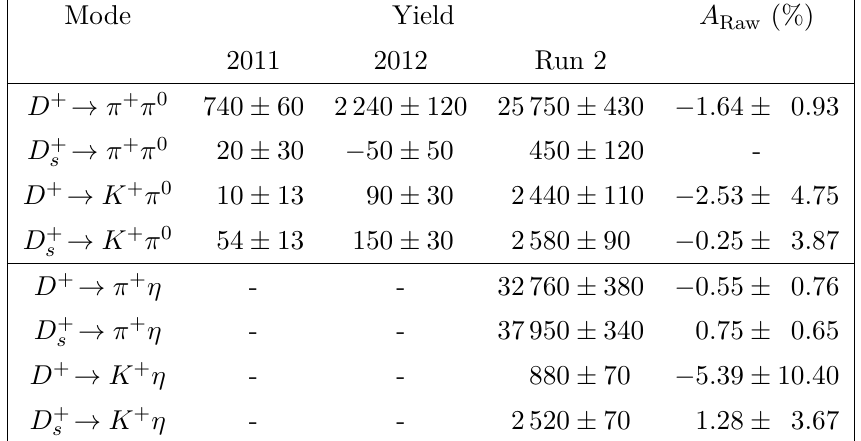
Table 1. Signal yields in each running period and corresponding raw asymmetries for D + and D + → h + η candidates. The uncertainties are ( s )